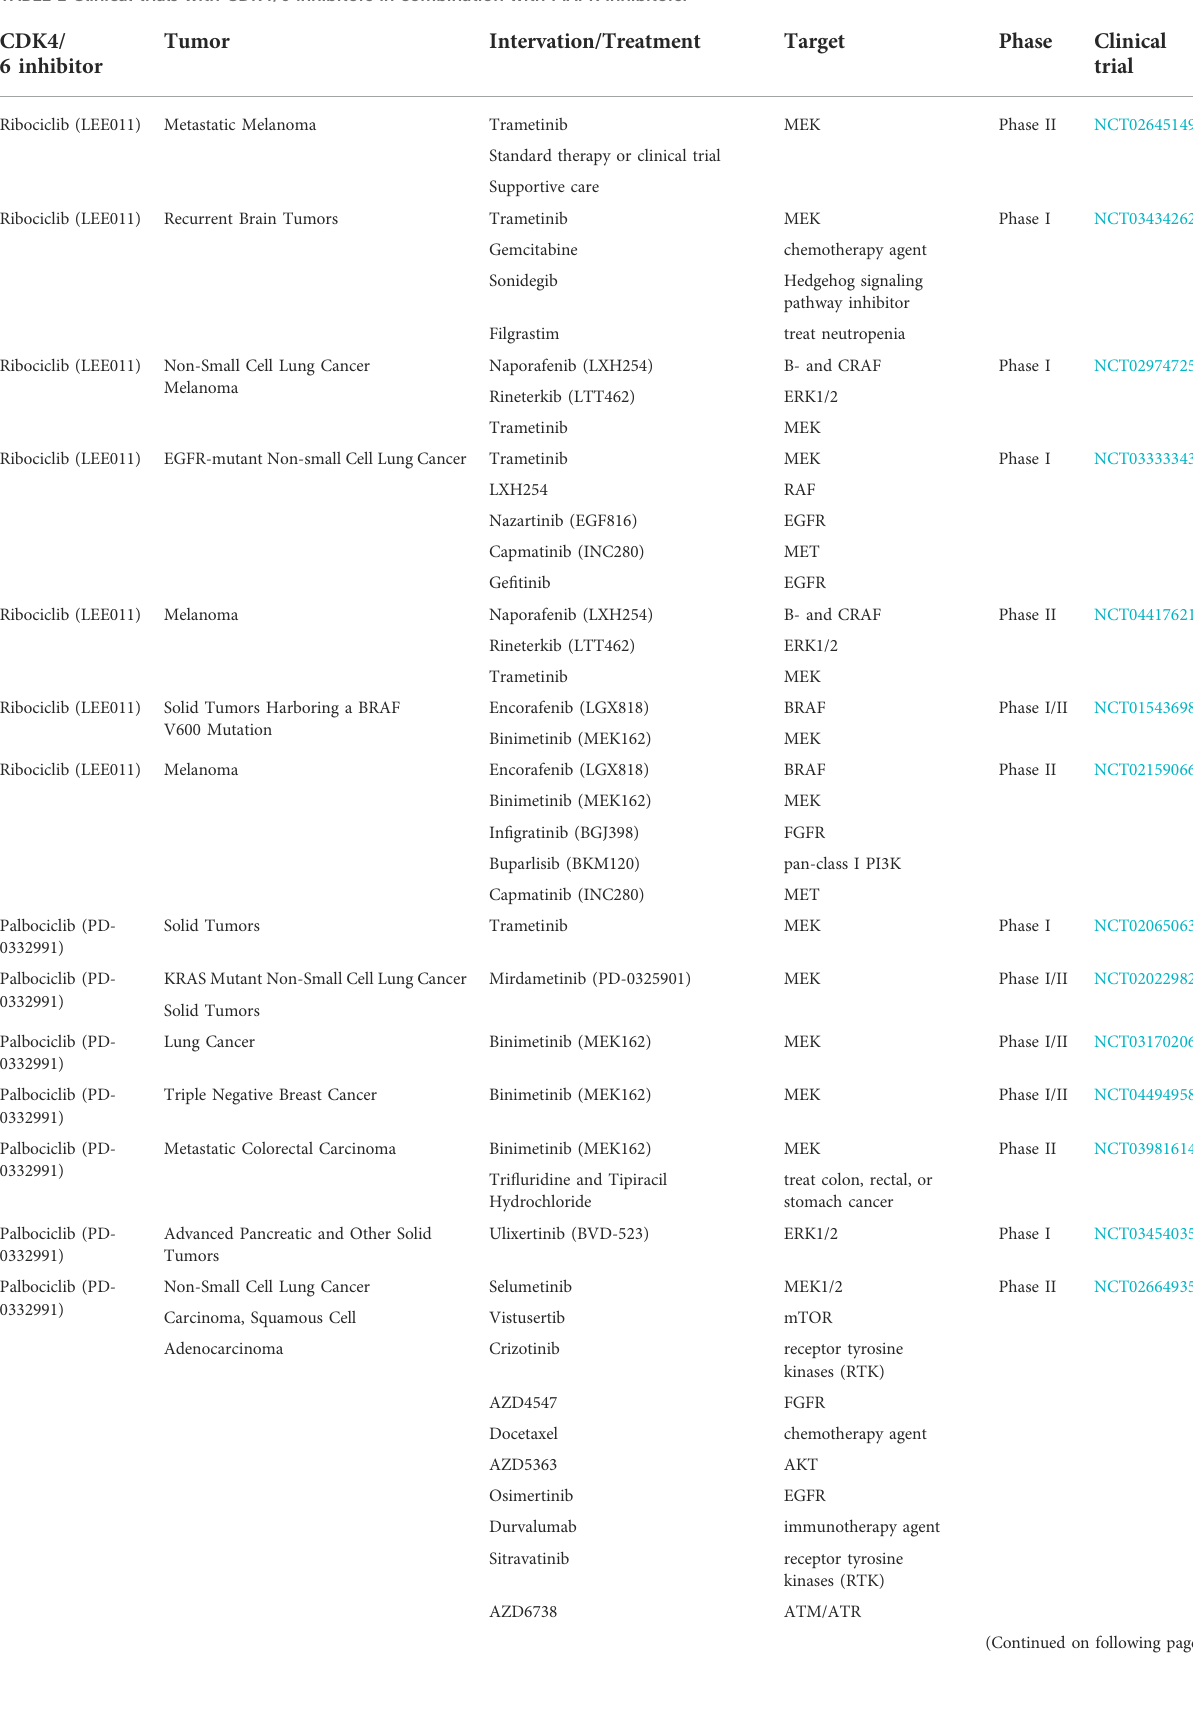
TABLE 1 Clinical trials with CDK4/6 inhibitors in combination with MAPK